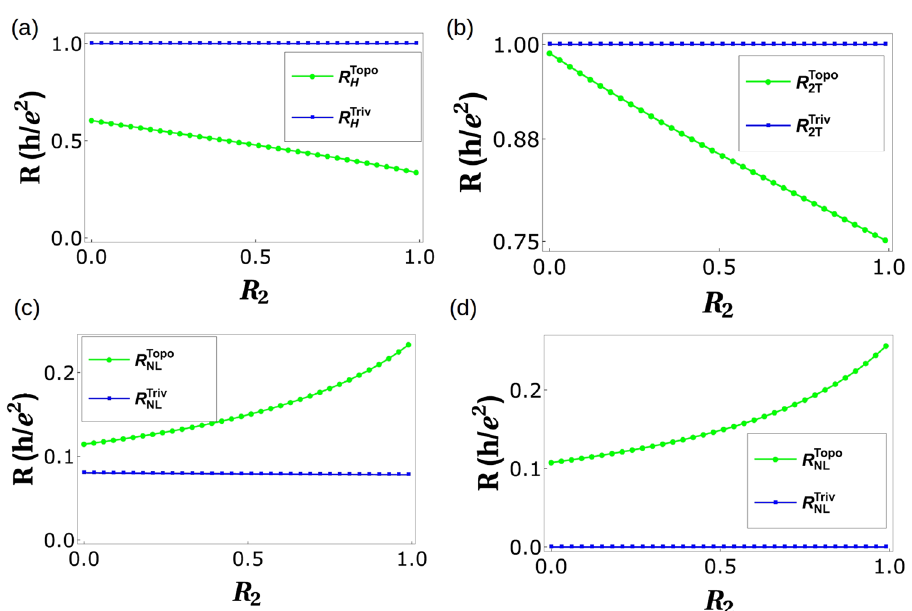
Figure 5. R H , R 2 T and R NL under the effect of inelastic scattering. ( a ) Hall resistance vs. Disorder R 2 with parameters R 4 = 0.5 and spin-flip probability f = f 0 = 0.5, ( b ) Two terminal resistance vs. Disorder R 2 with parameters R 4 = 0.5 and spin-flip probability f = 0.5, f 0 = 0.5, ( c ) Non-local resistance vs. Disorder R 2 parameters R 4 = 0.5 and spin-flip probability f = 0.3, f 0 = 0.3, ( d ) Non-local resistance vs. Disorder R 2 parameters R 4 = 0.5 and spin-flip probability f = 0.5, f 0 = 0 and second, fourth, sixth... paths form a infinite series with total transmission probability So, the total transmission probability is sum of the two and is written as T 23 as in Eq. (15). Choosing reference potential V 3 = 0, and I 2 = I 4 = 0 (as 2 and 4 are voltage probes) we derive local (two probe) resistance in absence of any disorder as = = − =